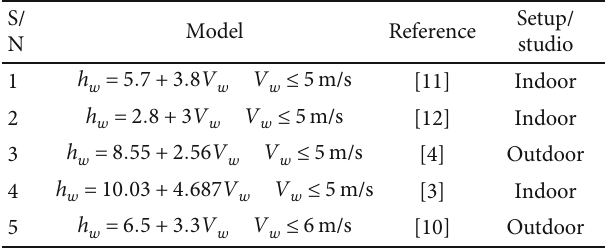
Table 1: Models developed by previous